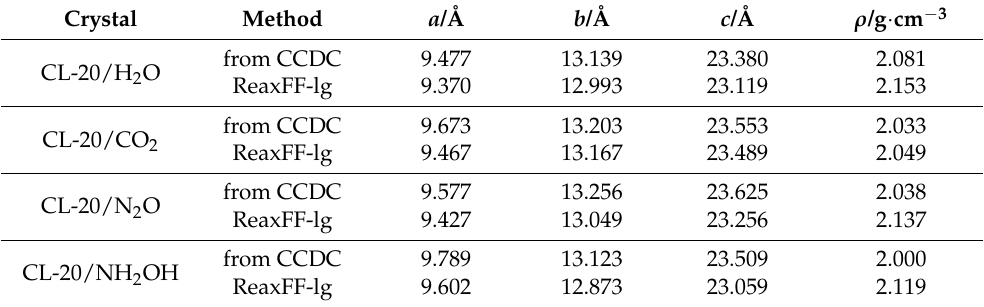
Table 4. Comparison of lattice parameters and density of